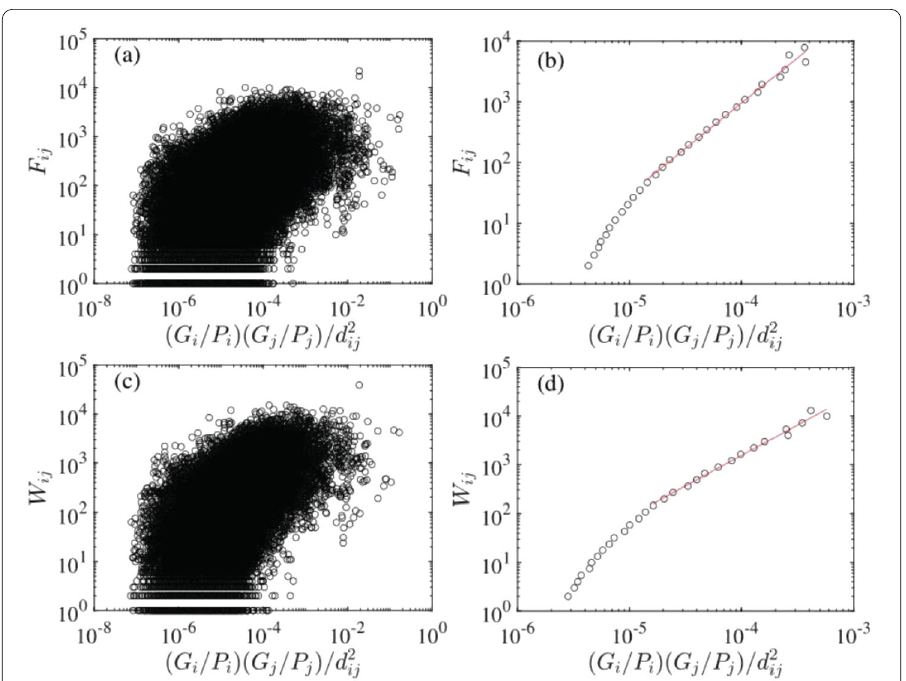
Figure 7 Testing the traditional gravity law with per capita GDP for the directed and undirected freight highway transportation networks constructed over five months. ( a ) Scatter plot of F ij with respect to ( G i / P i )( G j / P j )/ d 2 for the directed network. ( b ) Binning plot of F ij with respect to ( G i / P i )( G j / P j )/ d 2 ij network. ( c ) Scatter plot of W ij with respect to ( G i / P i )( G j / P j )/ d 2 ij for the undirected network. ( d ) Binning plot of W ij with respect to ( G i / P i )( G j / P j )/ d 2 ij for the undirected